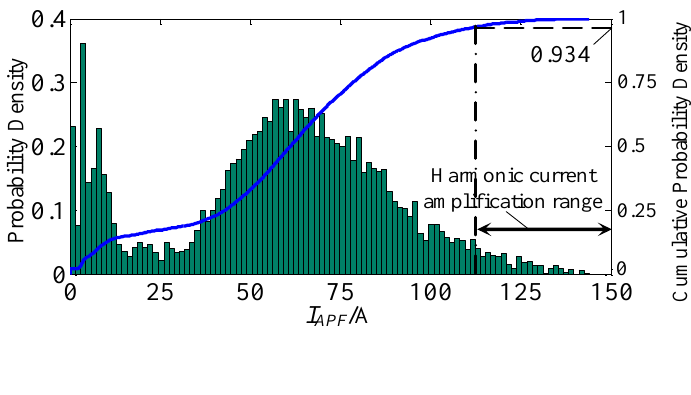
Figure 14. Statistical distribution of the APF